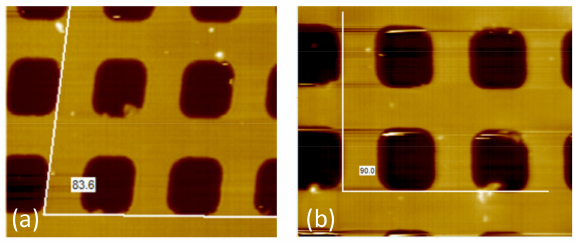
Figure 10. Imaging results of the oblique-mounted ( a ) and normal-mounted ( b )